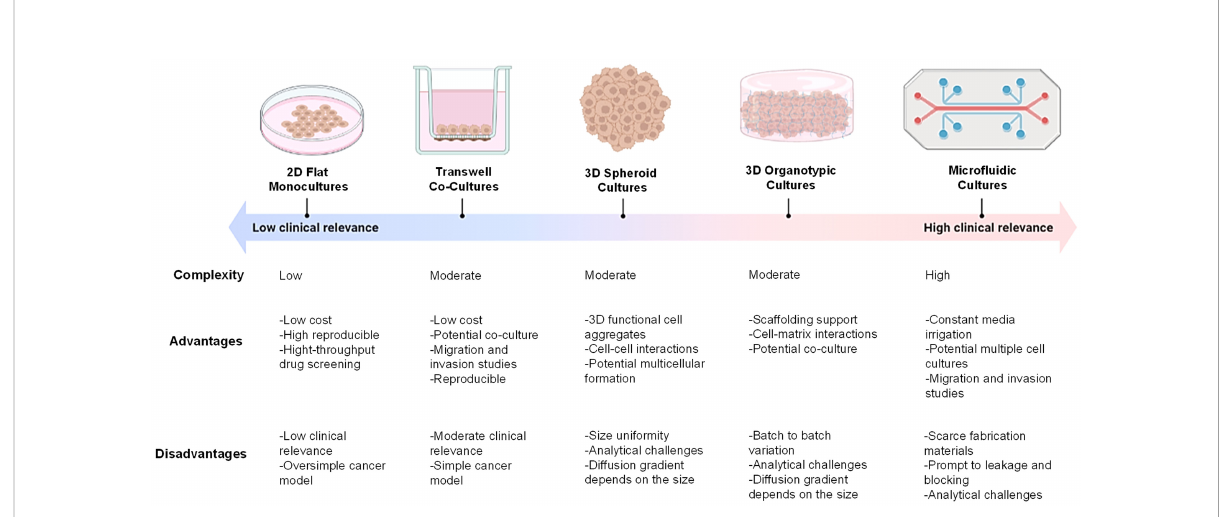
FIGURE 3 Common in vitro cancer models. Two-dimensional (2D) fl at monolayer cell cultures grown on plastic or glass surfaces. Transwell systems with Boyden ’ s chamber inserts for cellular cocultures. 3D spheroid-based systems by forced aggregation of cells into a 3D construct. 3D organotypic systems by culturing cells within a matrix such as a hydrogel. Micro fl uidic-based culture systems by culturing cells within a microchannel with fl uid circulation. Figure created with